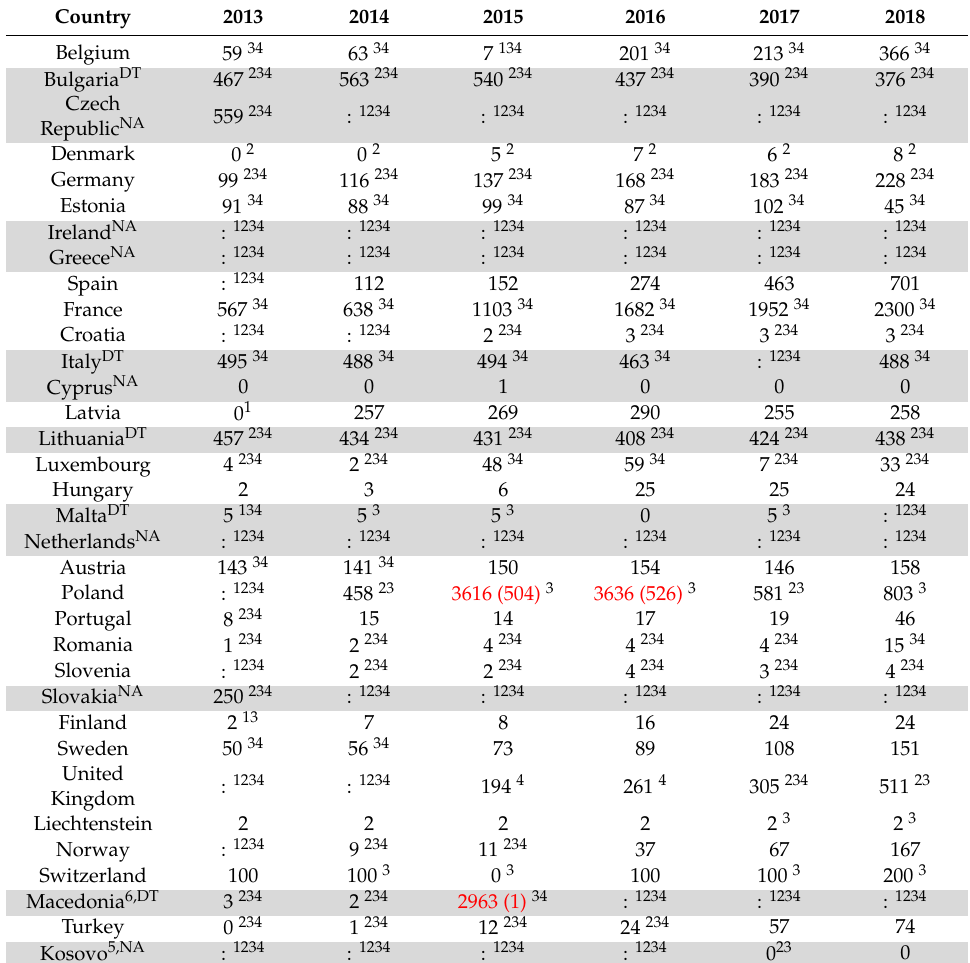
Table 2. Motor coaches, buses, and trolley buses, by four types of motor energy (electricity, hybrid diesel-electric, plug-in hybrid diesel-electric, and hydrogen and fuel cells) [Source: own study based on data retrieved from